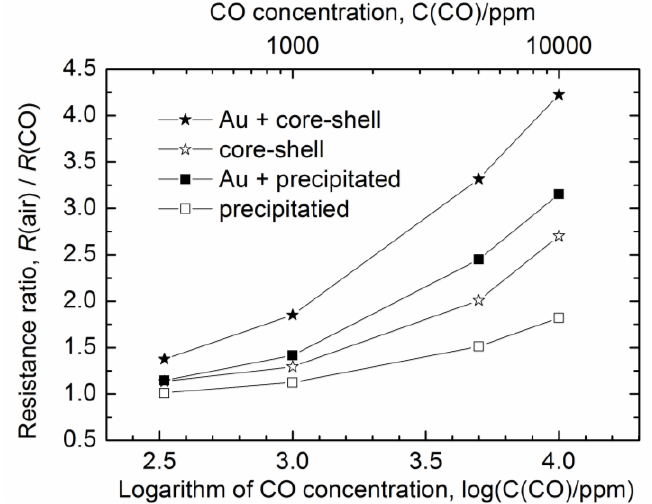
Figure 4. Relationship between the CO concentration in the tested air sample and the responses of various sensors at 450 °C. Au + core-shell: sensor based on a thick film formed from the core-shell nanoparticles. The thick film was fired at 1,000 °C and Au nanoparticles subsequently incorporated into it; core-shell: sensor based on a thick film prepared from the core-shell nanoparticles and fired at 1,000 °C; Au + precipitated: sensor based on a thick film formed from the precipitated nanoparticles. The thick film was fired at 950 °C and Au nanoparticles subsequently incorporated into it; and precipitated: sensor based on a thick film prepared from the precipitated nanoparticles and fired at 950